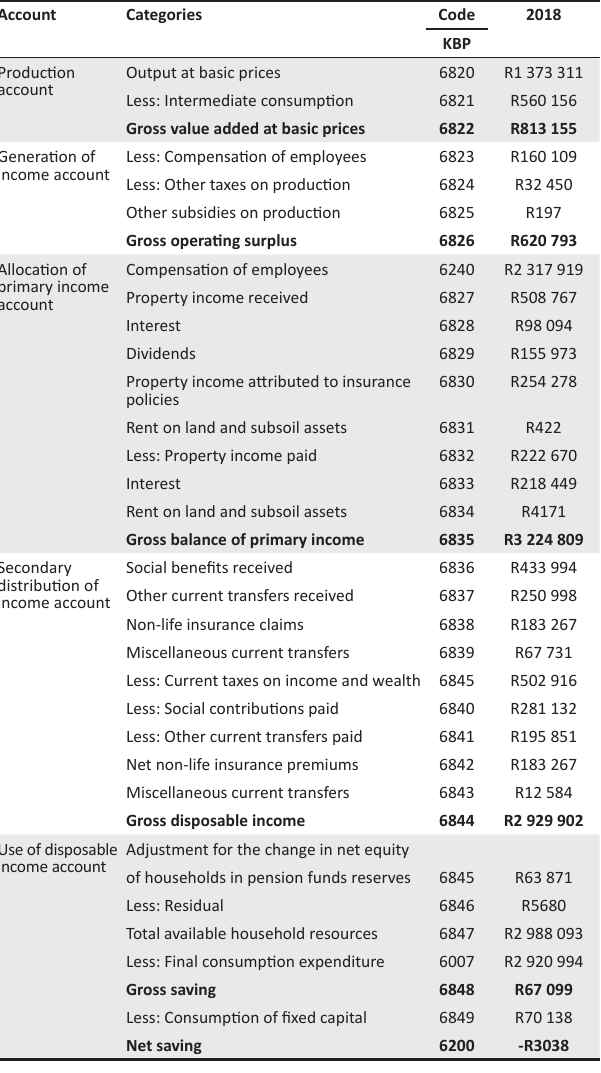
TABLE 1: Production, distribution and accumulation accounts of South African households, 5 2018 (R